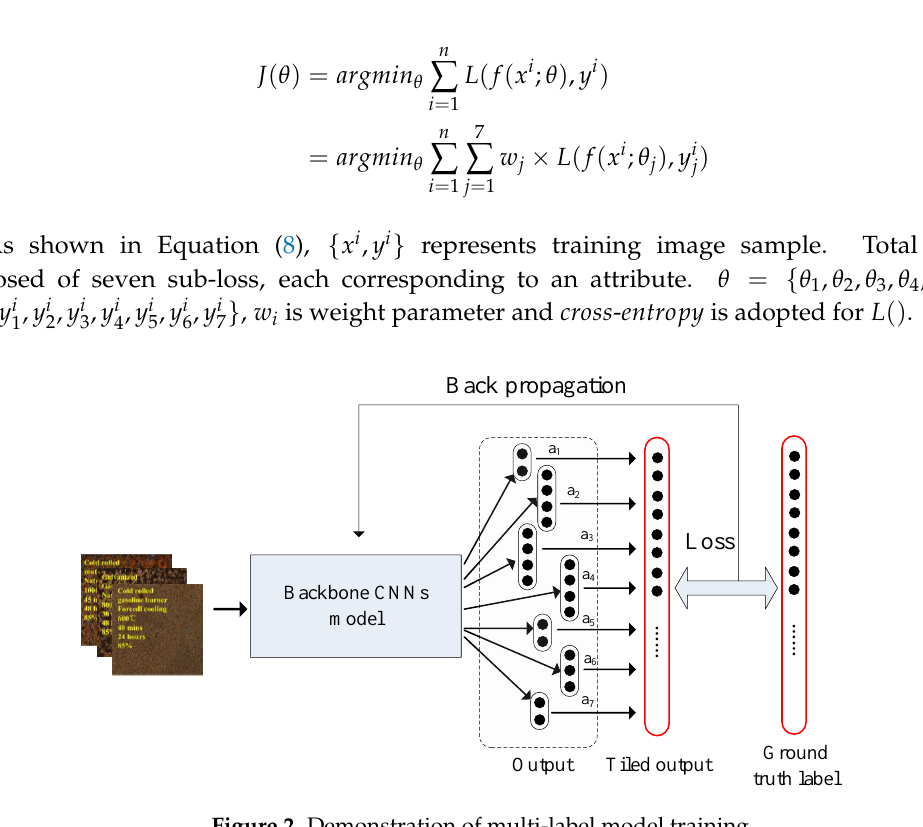
Figure 2. Demonstration of multi-label model